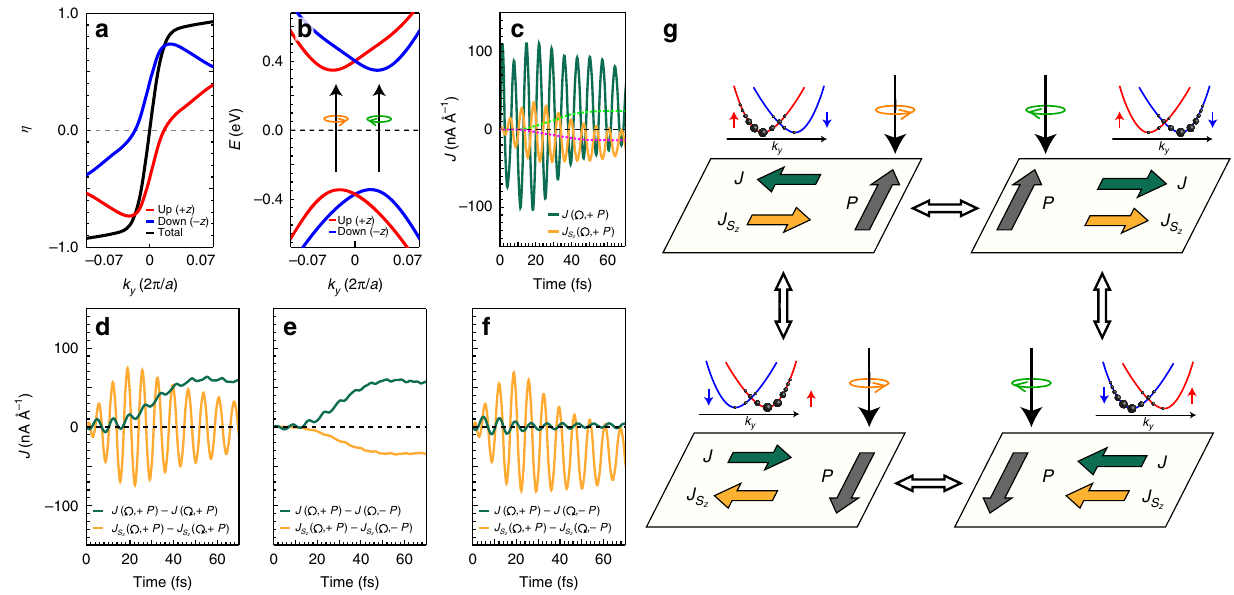
Fig. 5 Switchable charge and spin photogalvanic effects. a The calculated circular dichroism ( η ) for the band-edge transitions near the X valley. The adsorption of the left-handed (right-handed) light prevails when η is greater (smaller) than zero. b Spin-selective circular dichroic excitation near the X valley. The spinup (spindown) states are marked by red (blue) lines. An orange (green) arrow represents the right-handed (left-handed) light. c Charge (green line) and spin (yellow lies) currents under the right-handed light, which were calculated by the time-dependent density functional theory method. The dashed guidelines (cyan and magenta) were obtained by averaging out the rapidly oscillating contributions and represent the charge and spin photocurrents, respectively. d – f The calculated charge (green line) and spin (yellow lines) current differences that are caused d by the photon helicity, e by the ferroelectric polarization, and f by both the photon helicity and the ferroelectric polarization. Here, the spin current in ( d ) and charge current in ( f ) gives no contribution after averaging out the oscillating contributions. This observation implies that the reversal of the photon helicity changes the direction of the charge current only, while the reversal of the ferroelectric polarization reverses the direction of both charge and spin photocurrents. g Schematic drawings of the circular photogalvanic effect being controlled by the helicity of the circularly polarized light and the ferroelectric polarization direction; the observations in ( c – f ) for four different combinations of the photon helicity and the ferroelectric polarization are depicted. In this way, one can independently control the direction of the charge and spin currents induced by the incident circularly polarized light. Here, the inversion and time-reversal operations are denoted by the vertical and the horizontal white arrows,